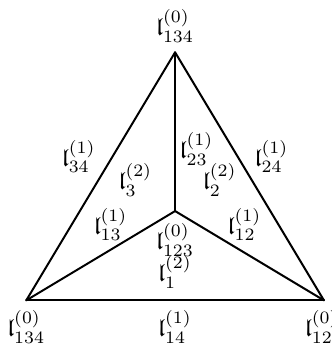
Figure 5 . Polyhedral decomposition of a 2-cycle L (2) = (cid:6) 4